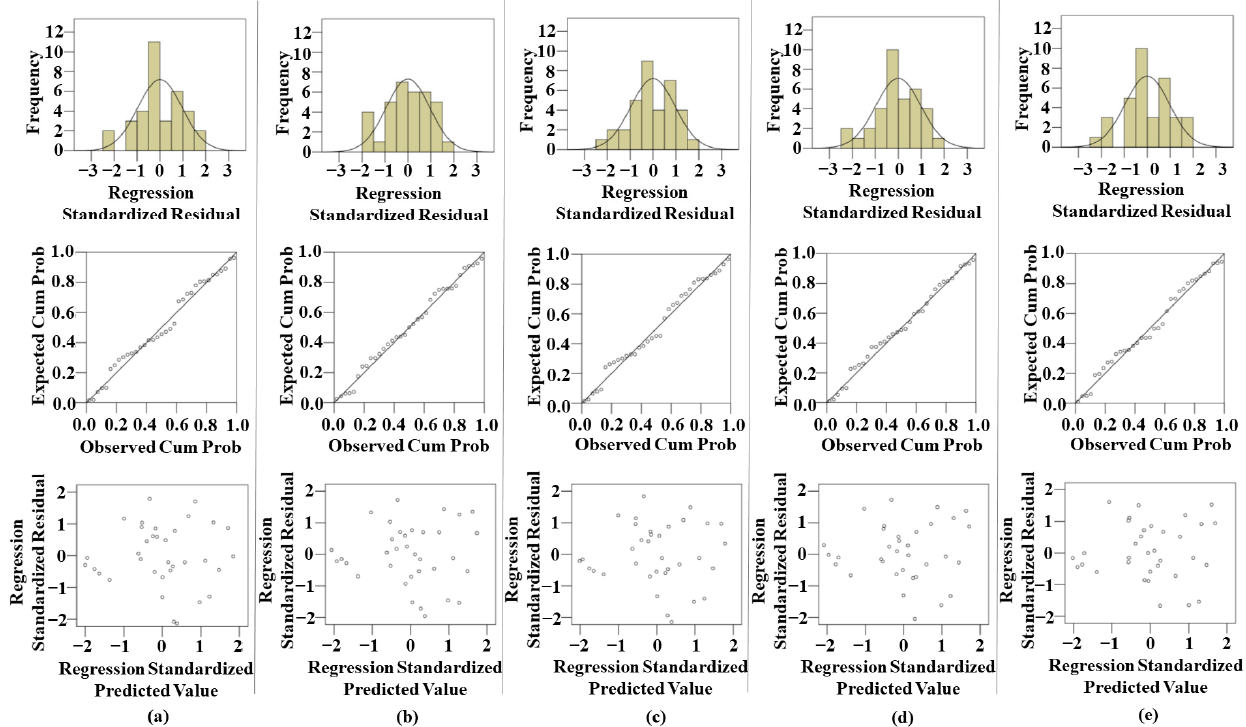
Figure 4. Residual analysis results of five multiple linear regression (MLR) models. ( a ) All color features; ( b ) principal component features extracted from all color features by principal component analysis; ( c ) average features of all colors; ( d ) principal component features extracted from principal component analysis of color average features; ( e ) R_mean, G_mean, B_mean, and Gray_mean.